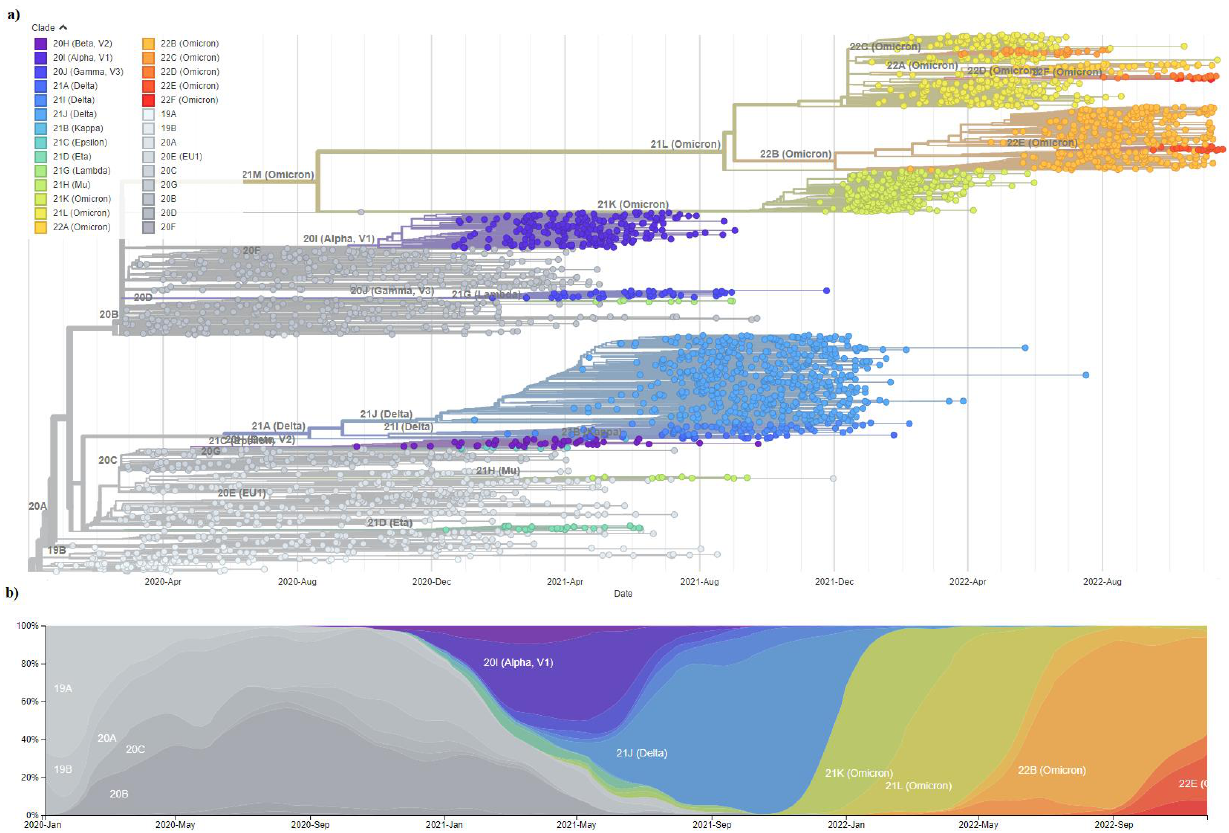
Figure 3. Global genomic epidemiology of severe acute respiratory syndrome coronavirus 2 (SARS- CoV-2) since the start of the coronavirus disease 2019 (COVID-19) pandemic. Visualisation of SARS- CoV-2 evolution and spread since the start of the pandemic was performed using Nextstrain A depiction of a subsample of 3059 genomes obtained between December 2019 and November 2022 from the GISAID database, with currently recognised SARS-CoV-2 variants indicated by different coloured branches on ( a ) a time-resolved phylogenetic tree. ( b ) Frequency visualisation by